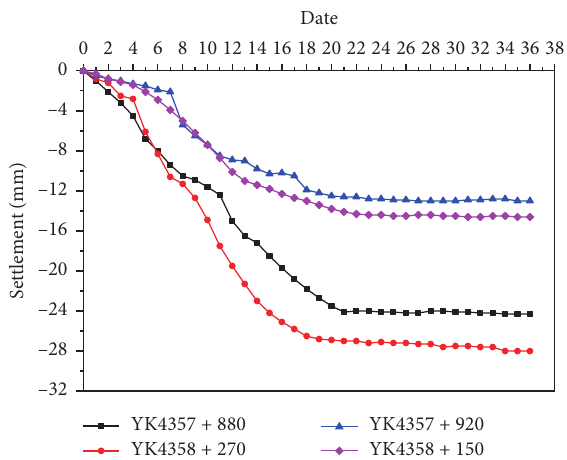
Figure 16: Development curve of vault